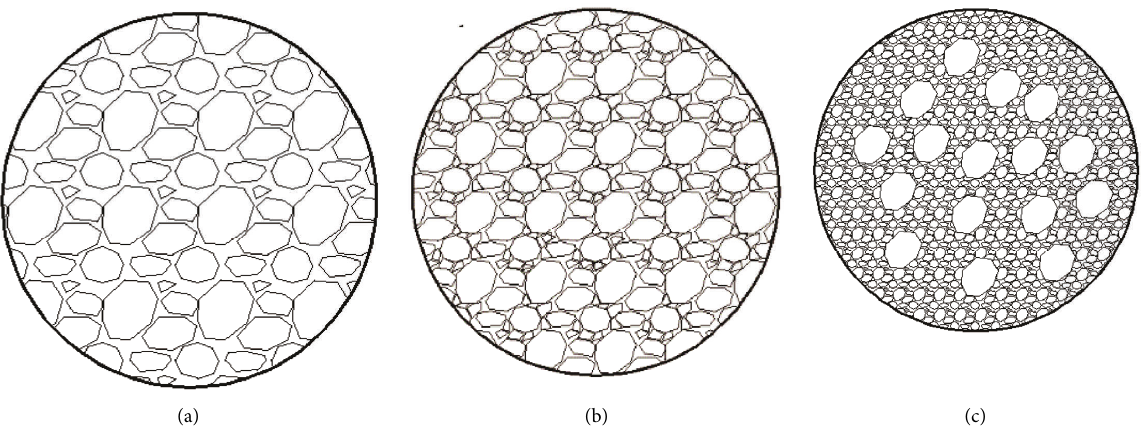
Figure 7: Stacking state of gangue particles.